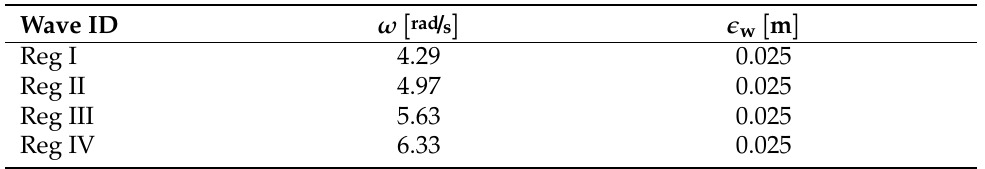
Table 2. Overview on the investigated four regular waves. The first table column presents the unique identifier for each regular wave, the second column the angular frequency and the last column the wave